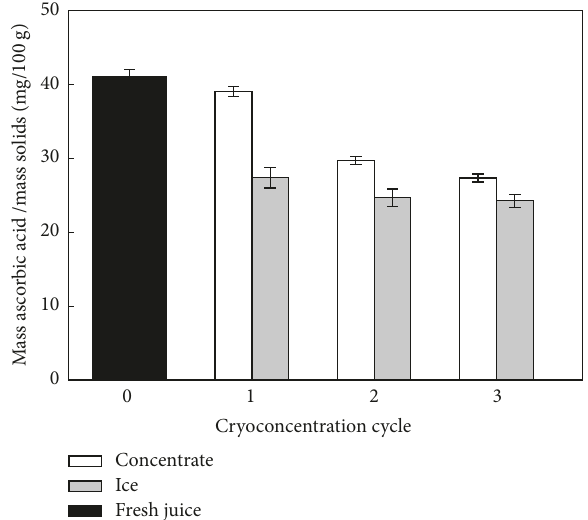
Figure 3: Evolution of the efficiency and percentage of concentrate as a function of the cryoconcentration cycle. Figure 4: Evolution of the ascorbic acid content (mg/100g solids) in